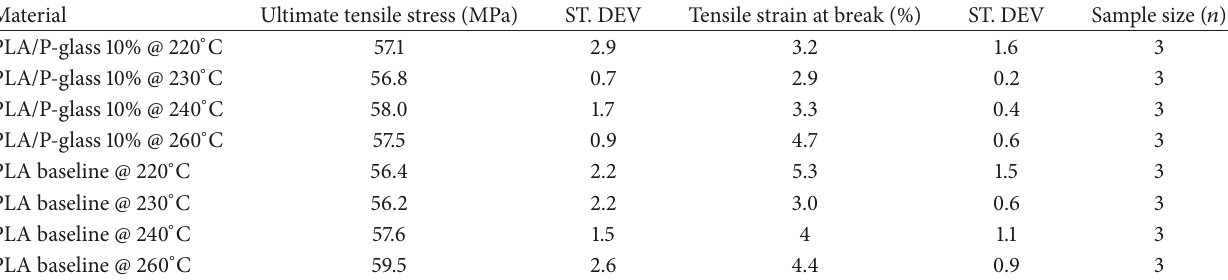
Table 9: Mechanical testing data for the PLA/P-glass 10% system where the filament was dried before printing at different temperatures.